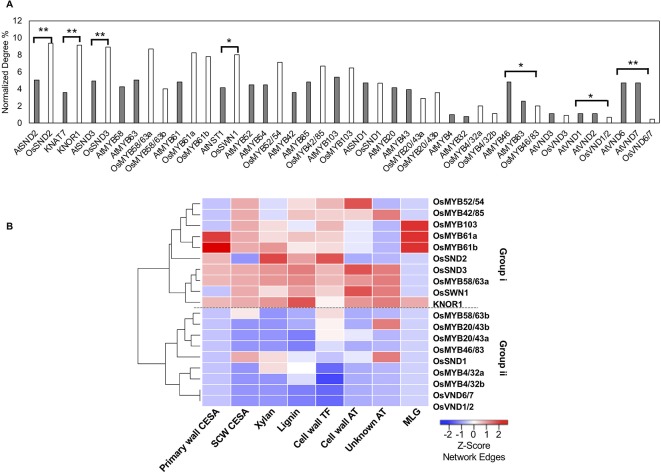
Rice (co-)orthologs of Arabidopsis cell wall transcription factors possess varied numbers of edges in the rice cell wall network. (A) Some transcription factor (co-) orthologs have a significantly different normalized number of interactions with cell wall genes within the rice (solid bars) and the Arabidopsis (hatched bars) networks. *indicates Fisher test p value < 0.05 ; **indicates Fisher test p value < 0.01. (B) Rice transcription factors cluster into two groups (i and ii) depending on the number of edges with different cell wall gene classes. The heatmap displays z-score normalization of the number of interactions with transcription factors for each group of cell wall-related genes, as extracted from the RCRN without edge cutoffs. See Supplementary Table 1 for a summary of gene abbreviation explanations and locus IDs.